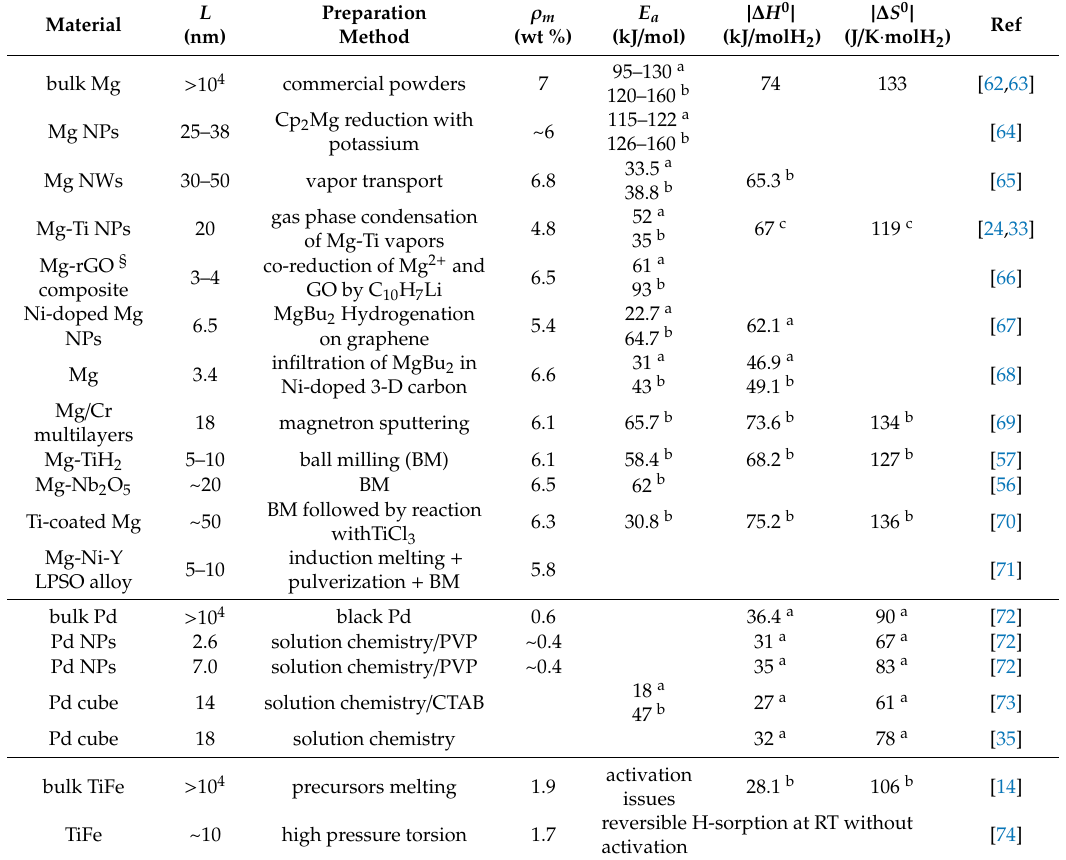
Table 1. H storage properties of selected nanomaterials: gravimetric reversible H storage capacity ρ m , apparent activation energy E a of sorption kinetics, and enthalpy formation / decomposition (in absolute value). L represents the scale of the nanostructure, e.g., grain size, nanoparticles (NPs) diameter, or layer thickness, depending on the system. The data of coarse-grained bulk materials are reported for